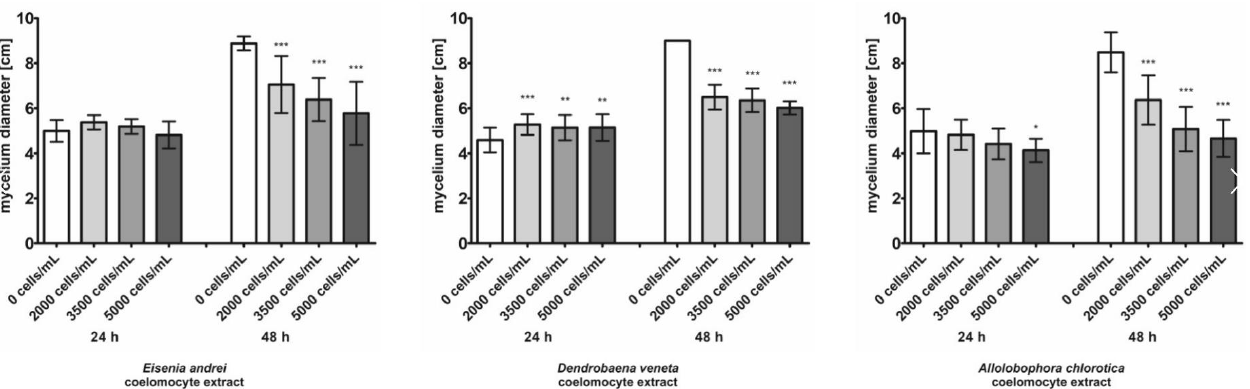
Figure 6. Growth (mean diameter ± SD) of Globisporangium irregulare mycelium 24 h and 48 h after treatment with Eisenia andrei , Dendrobaena veneta and Allolobophora chlorotica coelomic fluid extracts. Significant differences between control and groups treated with coelomocyte extracts are labeled with * ( p < 0.05), ** ( p < 0.01) and *** ( p < 0.001).